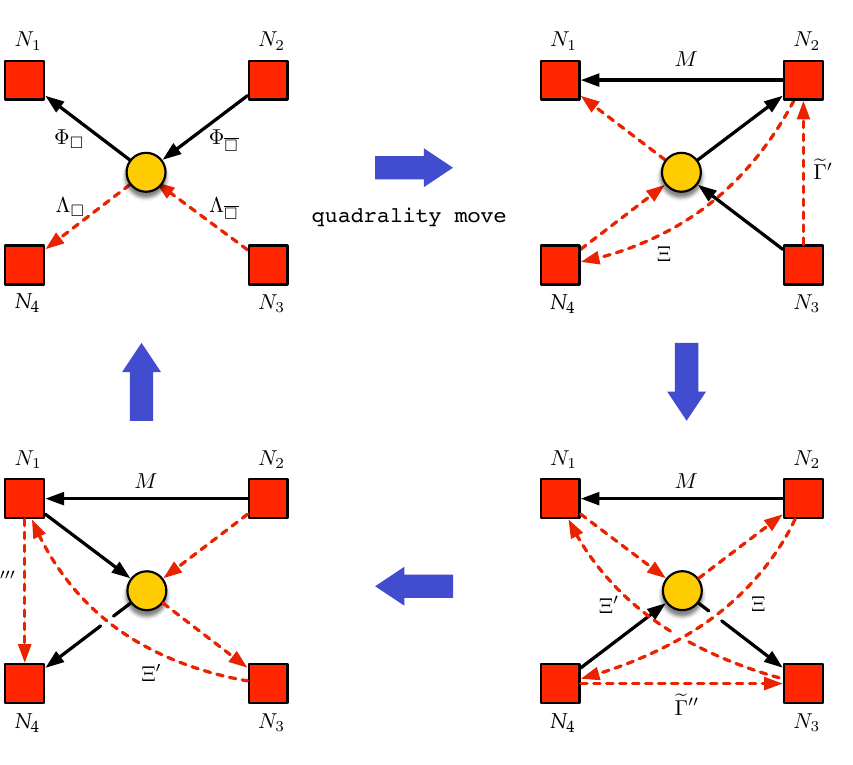
Figure 4 . The quadrality cycle for 0 d